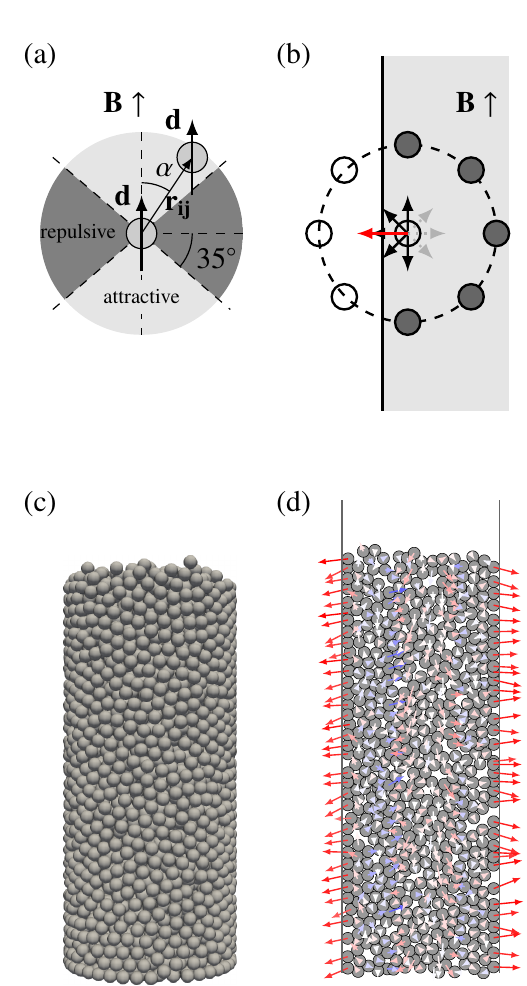
magnetic field, either repulsive or attractive depending on the relative position of the particles and the applied magnetic field, quantified by the angle α . (b) Forces acting on an o ff -axis par- ticle. (c) Random close packing generation using DPM simu- lations. (d) Forces representations inside a tube layer, averaged along θ , for a vertical magnetic field where red (resp. blue) vec- tors represents positive (resp. negative) radial